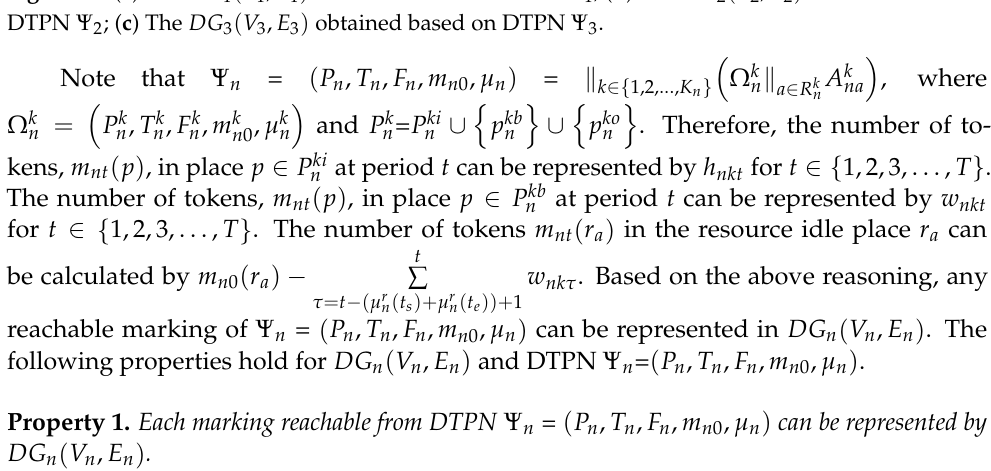
 ; ( b ) The ),( EVDG obtained 222 1  . 3